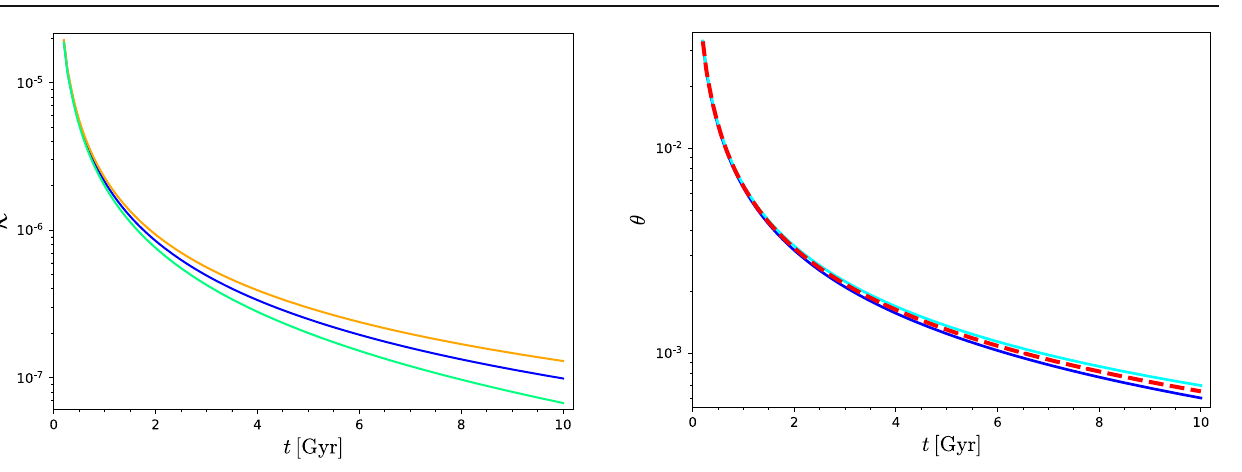
Fig. 8 The scalar curvature of the hypersurface of a constant time R as a function of time. We plot three cases with a different K parameter. Blue curve for K = 0, orange curve corresponding to K = 0 . 1 and light-green for the value K = − 0 . 1